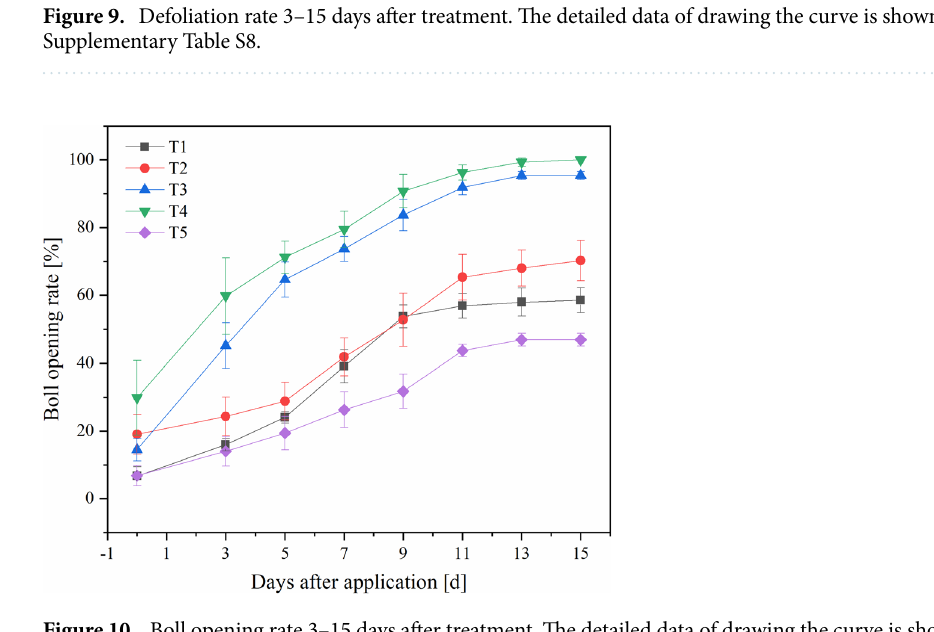
Figure 10. Boll opening rate 3–15 days after treatment. The detailed data of drawing the curve is shown in Supplementary Table